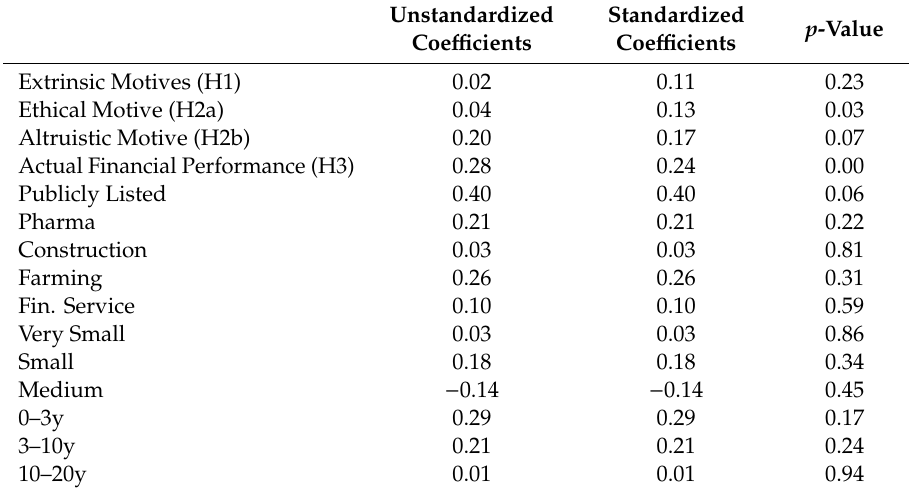
Table 7. This table presents the multiple regression results for testing the sub hypotheses by regressing the independent variables below on CSR the dependent